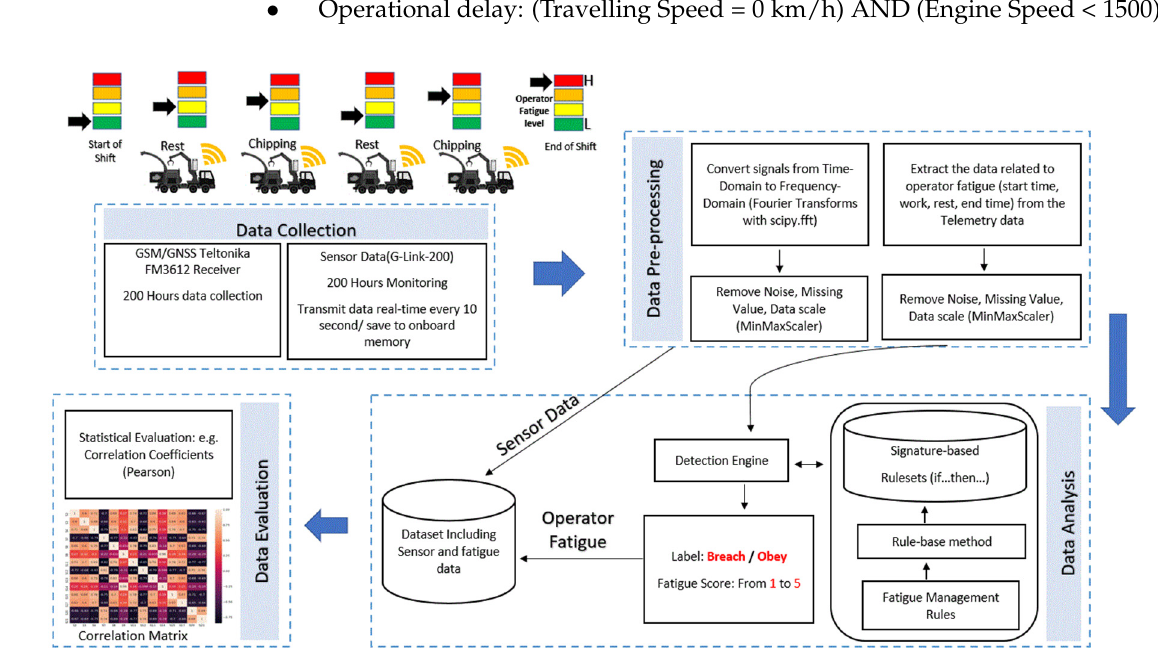
Figure 7. Correlation between operator fatigue and vibration sensor